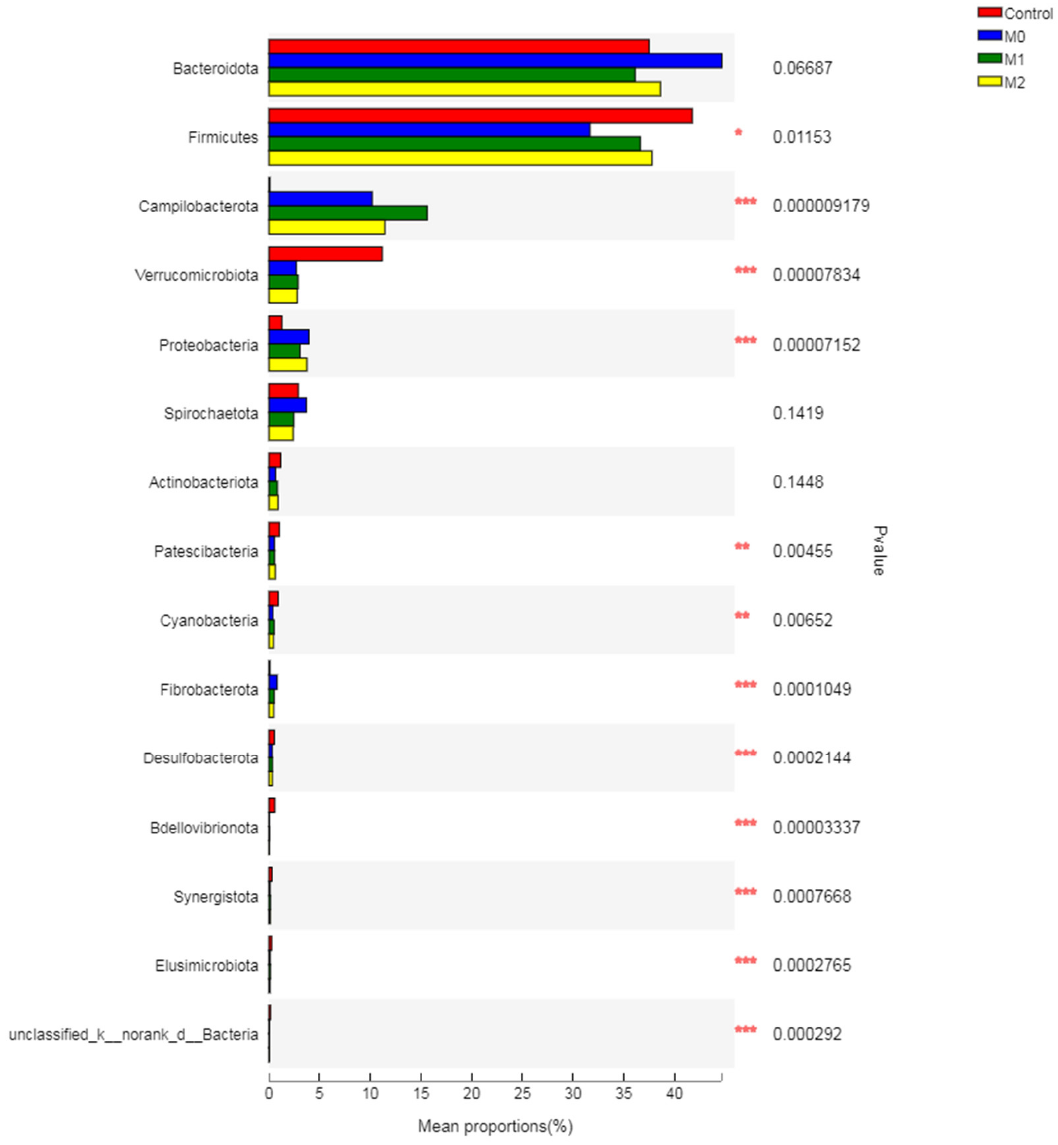
Figure 5. Relative abundance of different bacteria phyla across different treatment groups (Kruskal–Wallis H-Test with p < 0.05 as a significant difference).